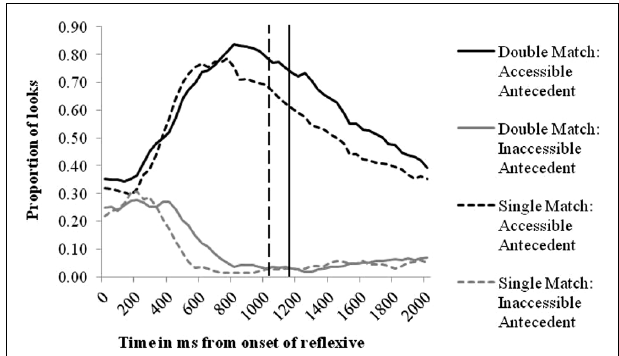
FIGURE 2 | Proportions of looks to potential antecedents.